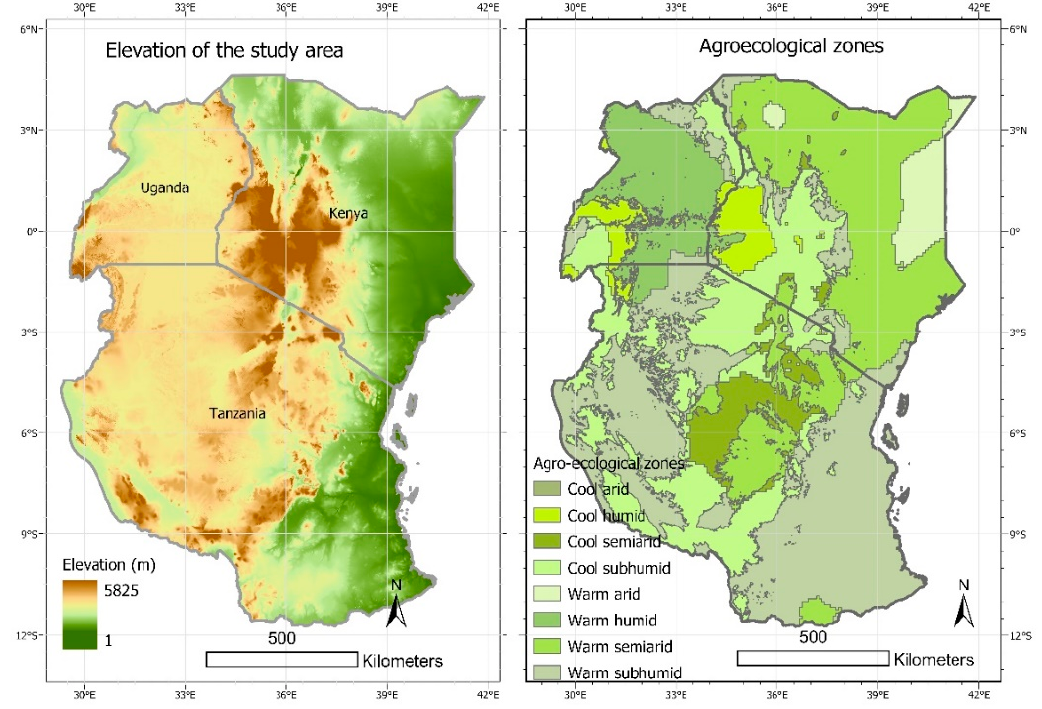
Figure 1. Location of the countries studied in East Africa, Kenya, Tanzania, and Uganda—showing the varied altitudinal ranges as well as the diversity of agro-ecological zones.